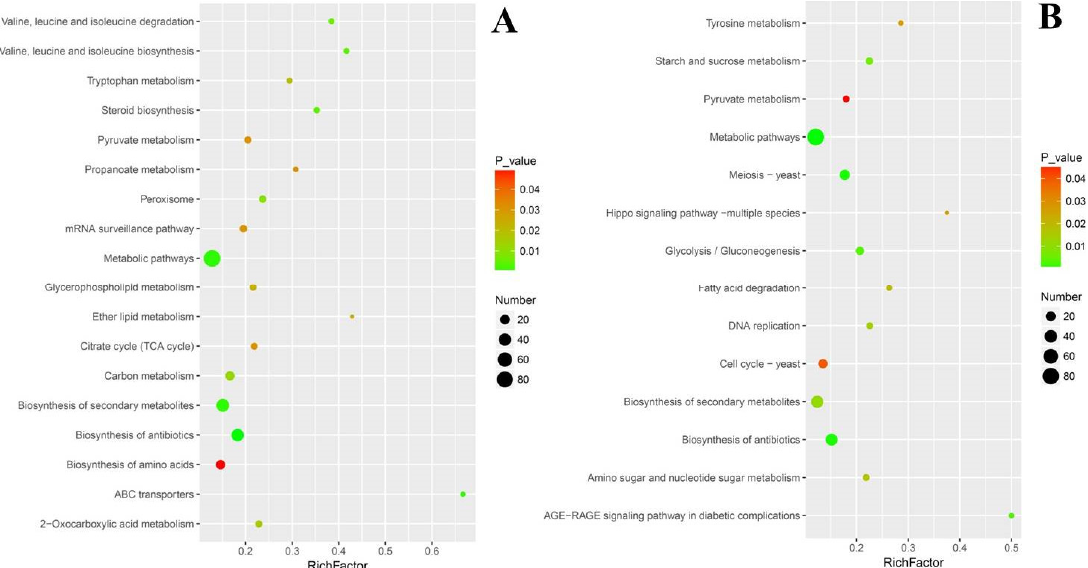
Figure 6. Rich-factor scatter plot of select pathway enriched with DEGs. (A) Up regulated DEGs. (B) Down regulated DEGs. Rich factor is the number ratio of differentially expressed genes to total annotated genes in a pathway. Dot areas show the number of DEGs, and the selection was based on the KEGG enrichment situation and pertinence to the metabolic blocks underpinning the fungal response to cuminal exposure.